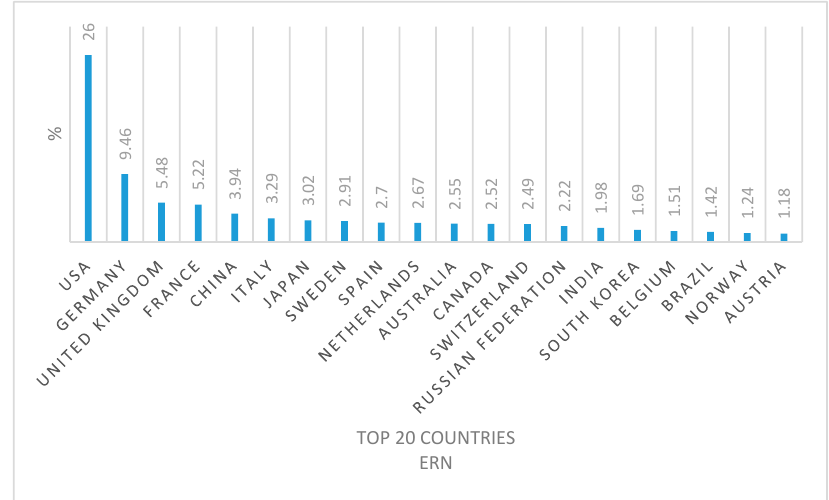
Figure 8. The top 20 countries most contributing to emergent radionuclide publications (2008–2018). The percentage of publications, expressed for each conventional and emergent radionuclide, has been calculated for all 98 and 85 countries respectively. However, we in tables 8 and 9 the results just for the top-20 countries of the two categories.